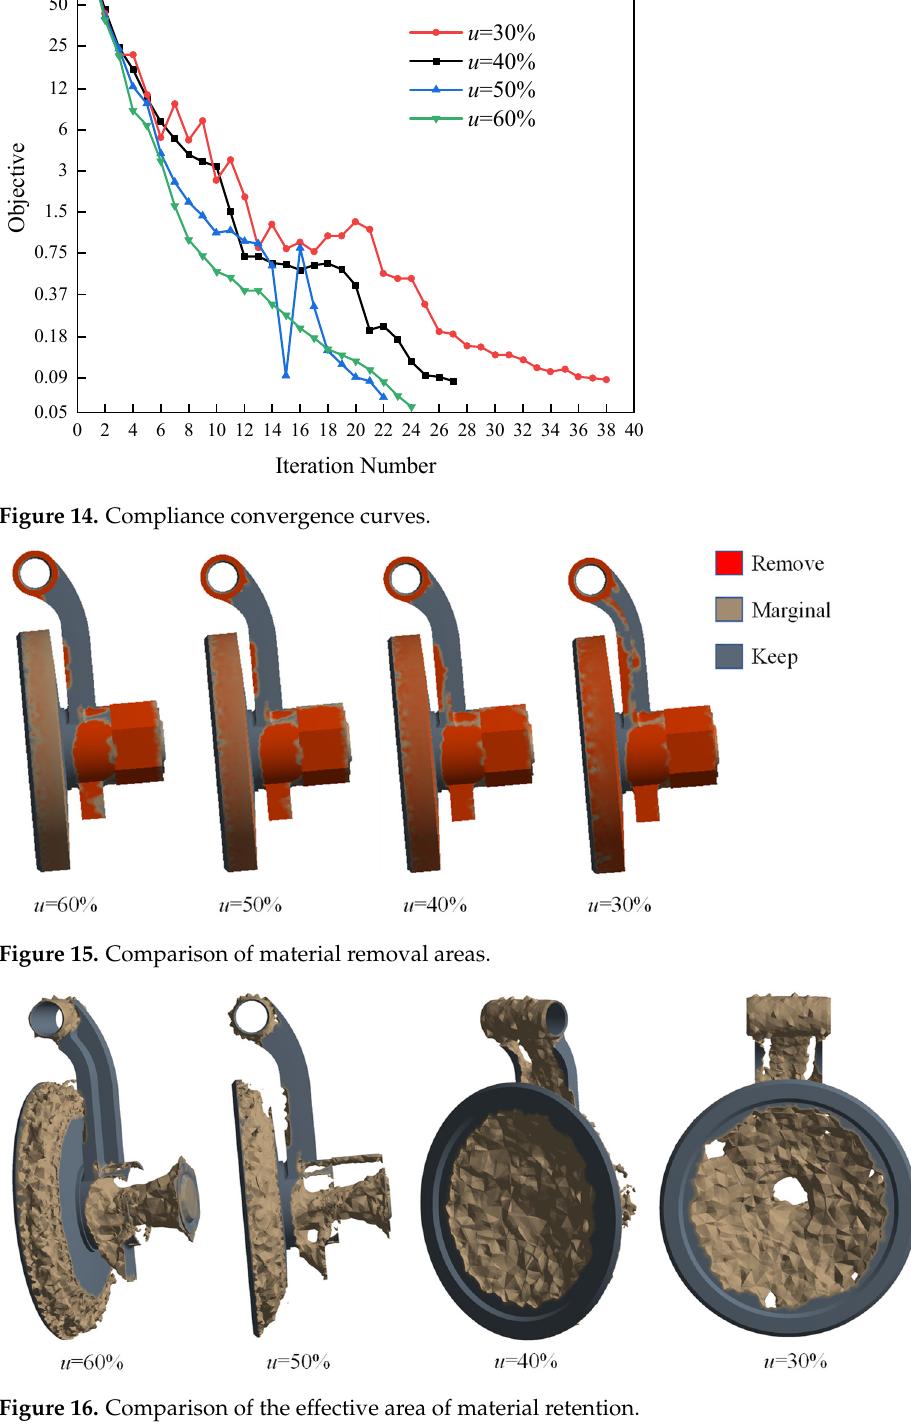
Figure 16. Comparison of the effective area of material retention.